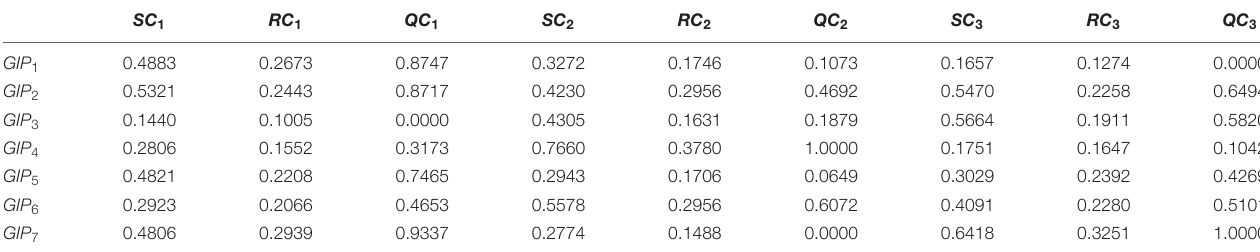
TABLE 10 | The computing result of academic research institutes.